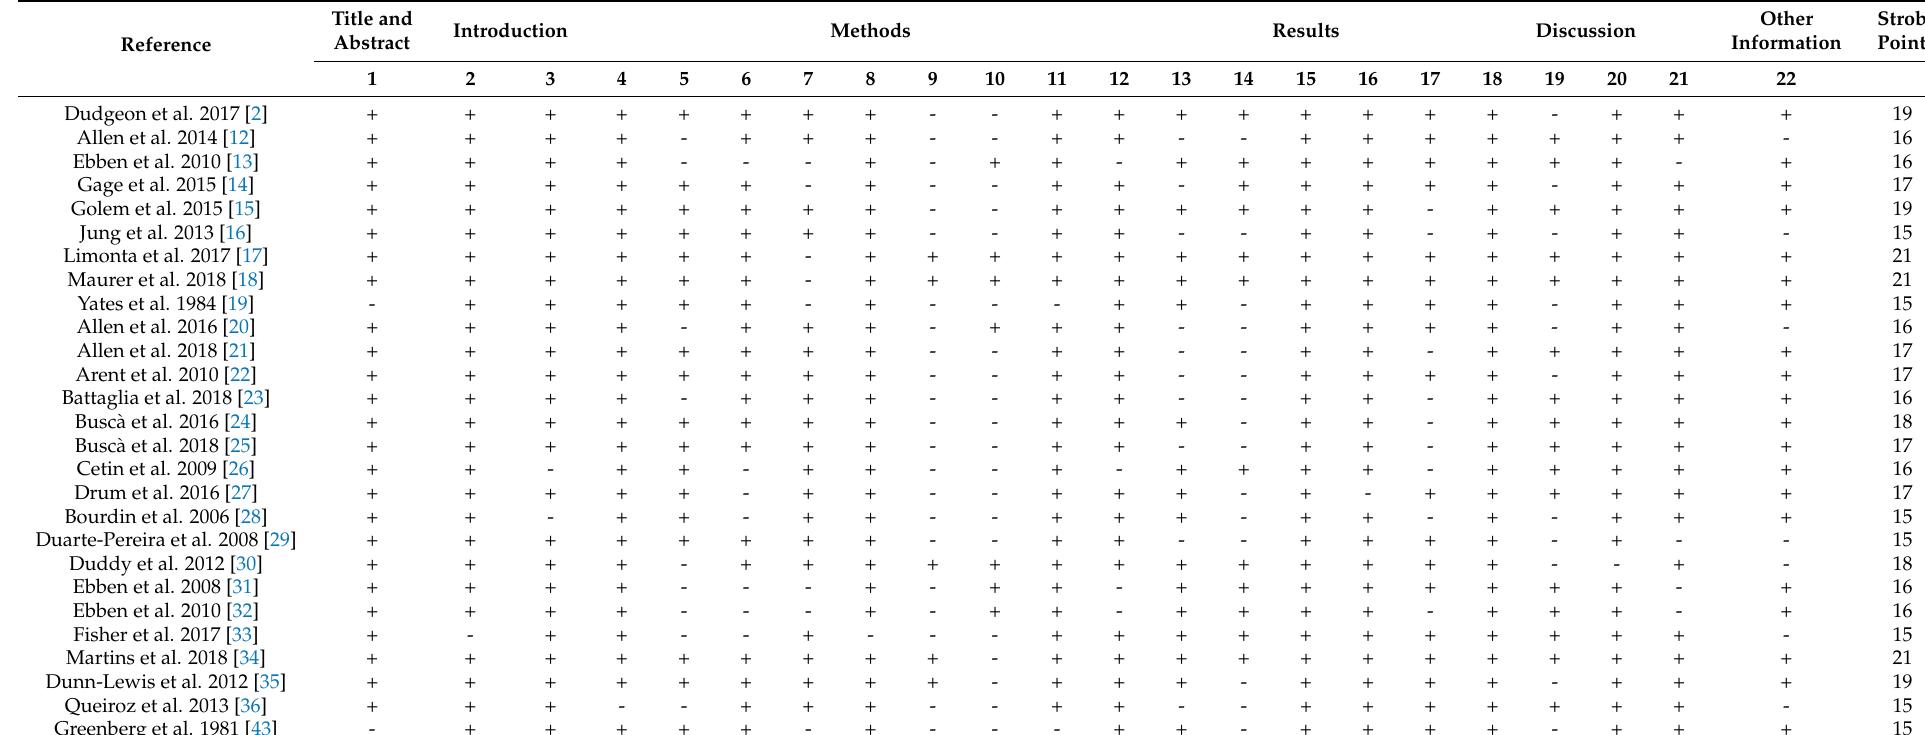
Table 1. The study quality analysis (STROBE